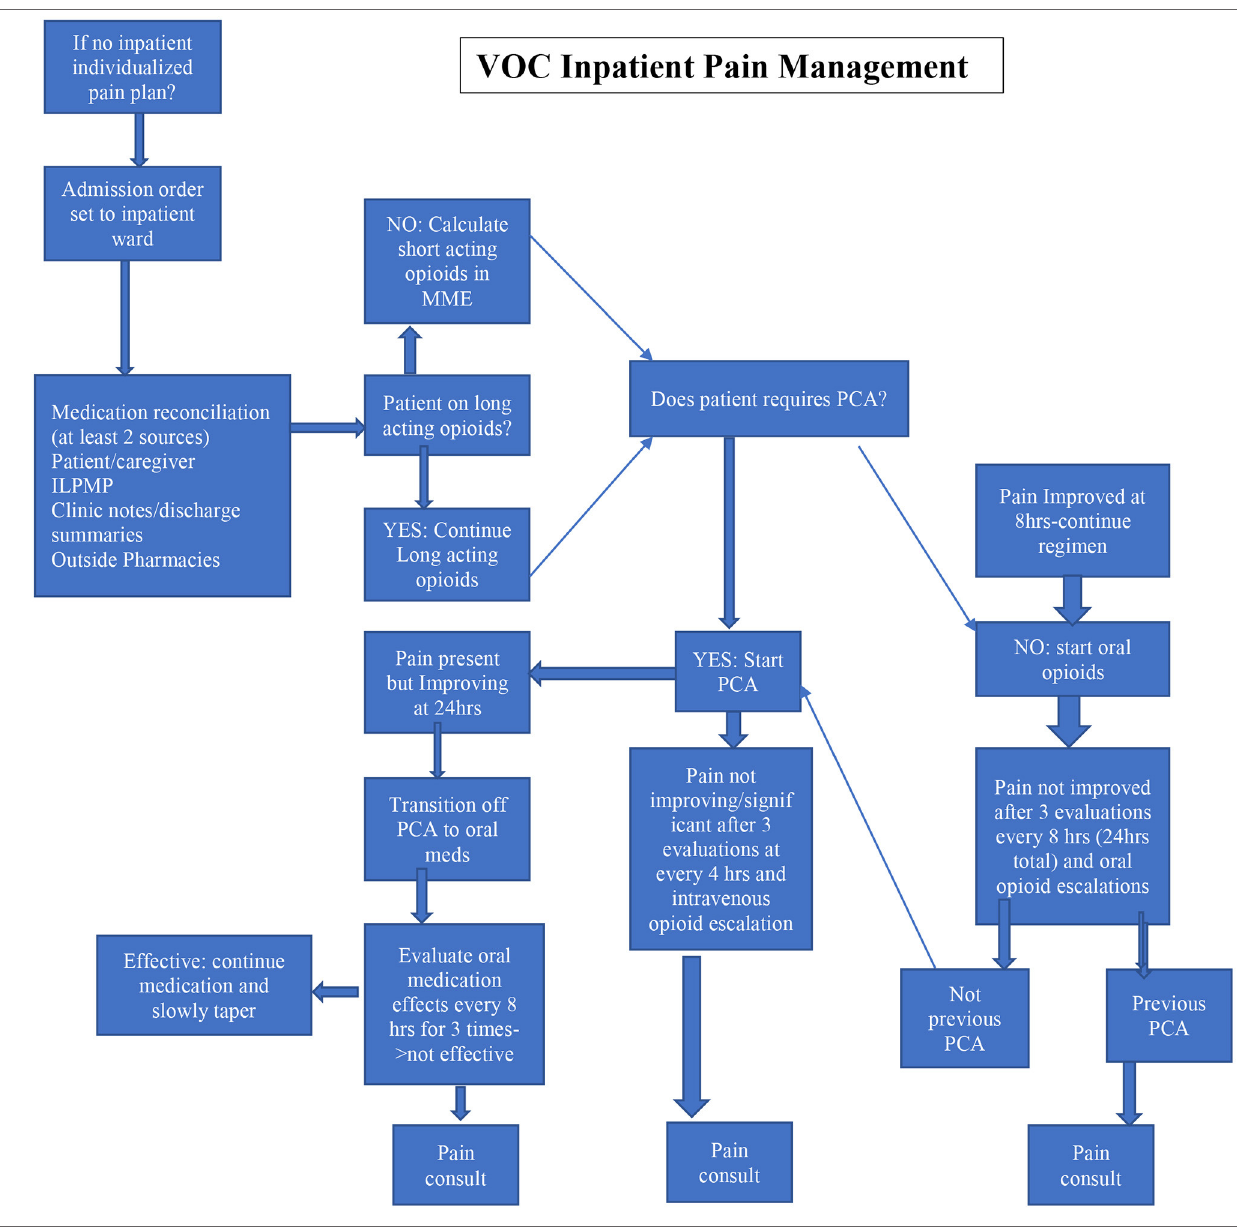
TABLE 7 | Vaso-occlusive (VOC) crisis inpatient pain